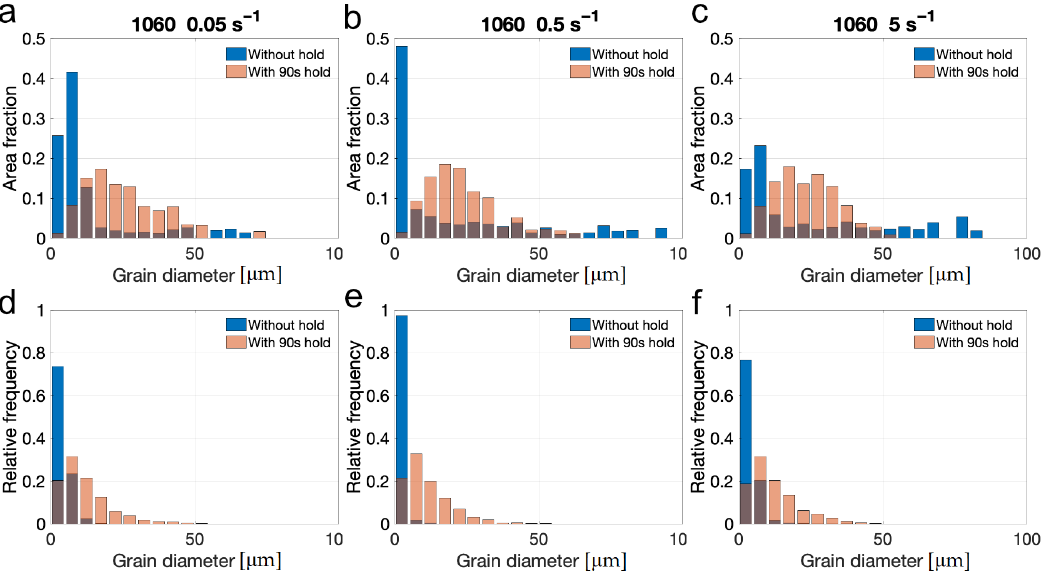
Figure 11. Grain size distribution for samples deformed at 1060 ◦ C. ( a – c ) area fraction, ( d – f ) relative (number) frequency. Diameter here refers to the equivalent circle diameter from EBSD. Please note that there are large grains falling outside the x -axis scale, see text.